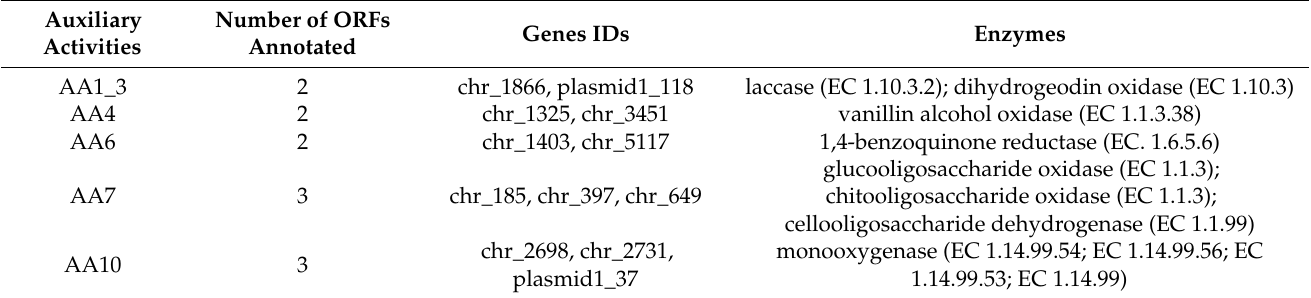
Figure 4. Annotation of B. cereus AH7-7 carbohydrate-active enzymes. Table 3. Category and number of annotated open reading frames (ORFs) of auxiliary activities family in B. cereus AH7-7.